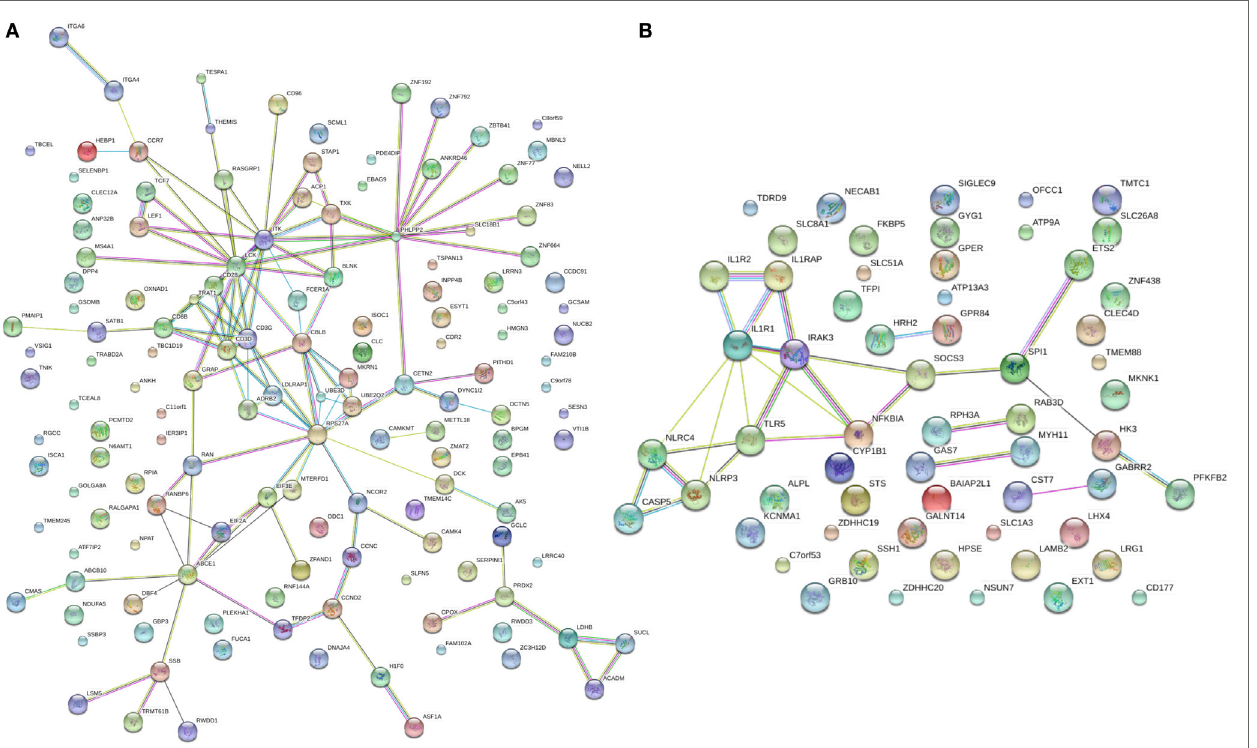
FiGURe 3 | STRING connectivity networks based on 210 differentially expressed genes. (a,B) Connectivity networks for significantly downregulated (a) and upregulated (B) genes from